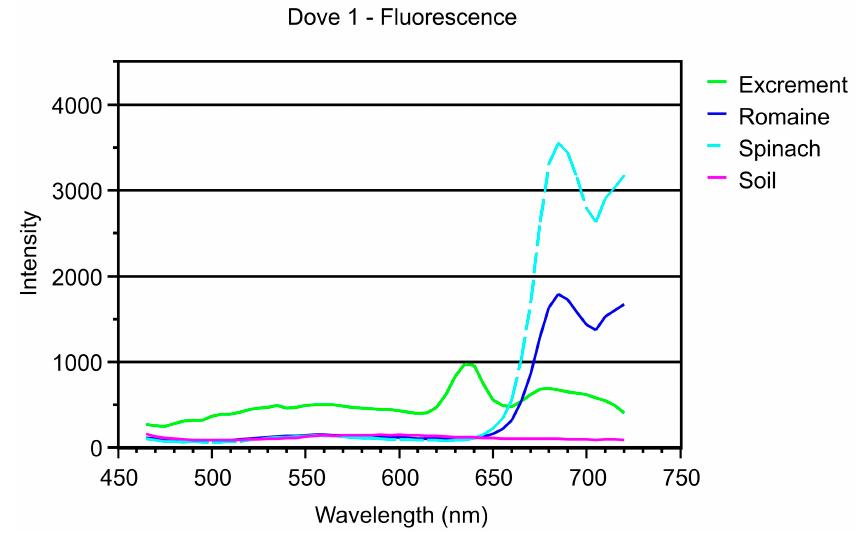
Figure 2. Fluorescence spectra for a dove dropping, romaine leaf, spinach leaf, and soil.